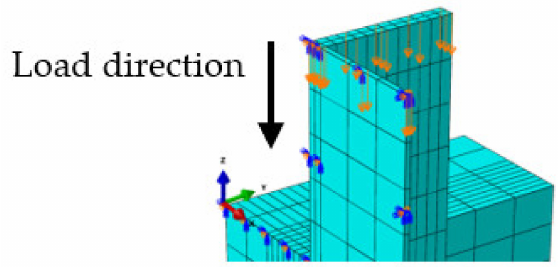
Figure 4. Load diagram of the FE modelling.